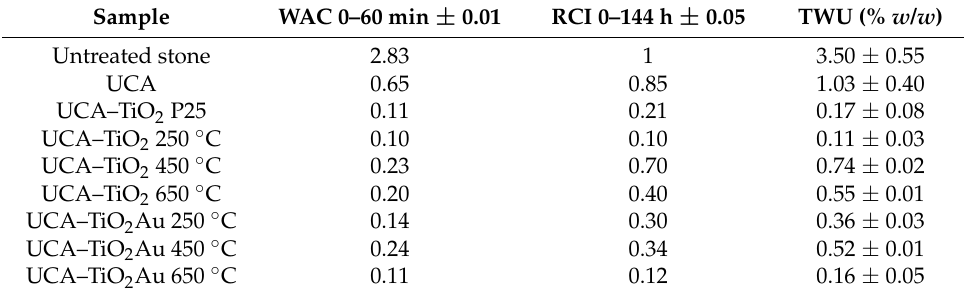
Table 3. Determination of water absorption coefficient (WAC), relative capillary index (RCI) and total water uptake values (TWU) obtained after 48 h by capillarity, according to UNI-EN 15801:2010 [38].